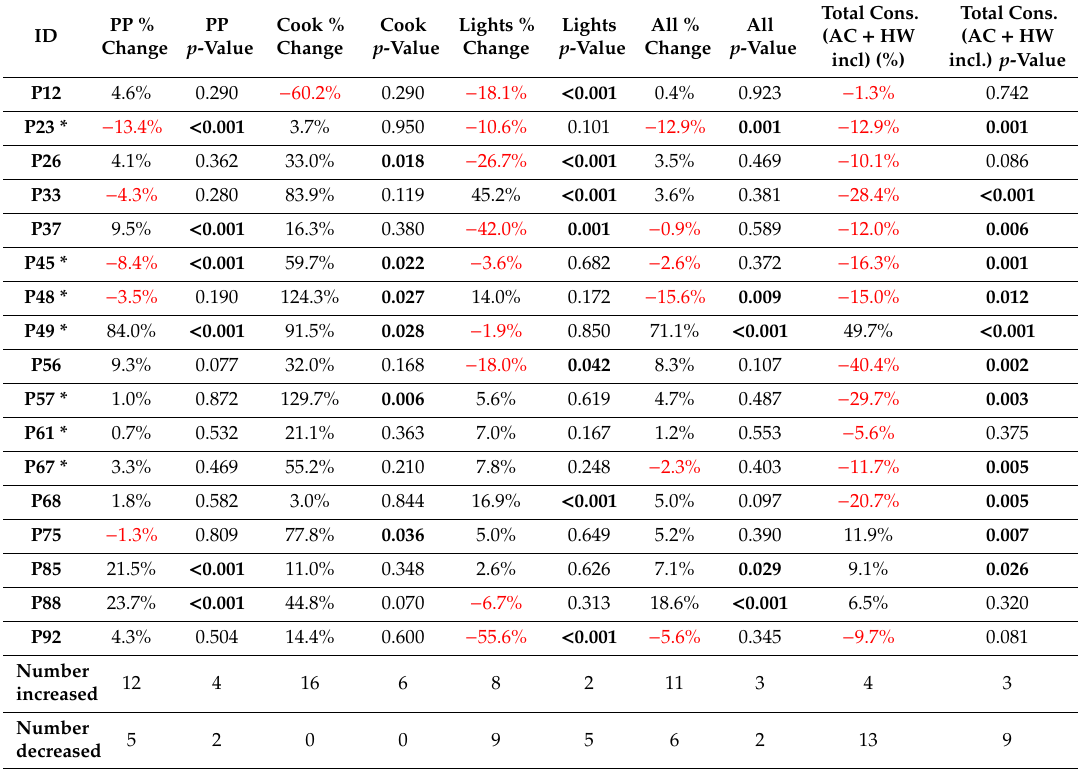
Table 8. Overall changes in average daily weekday energy use during lockdown vs.